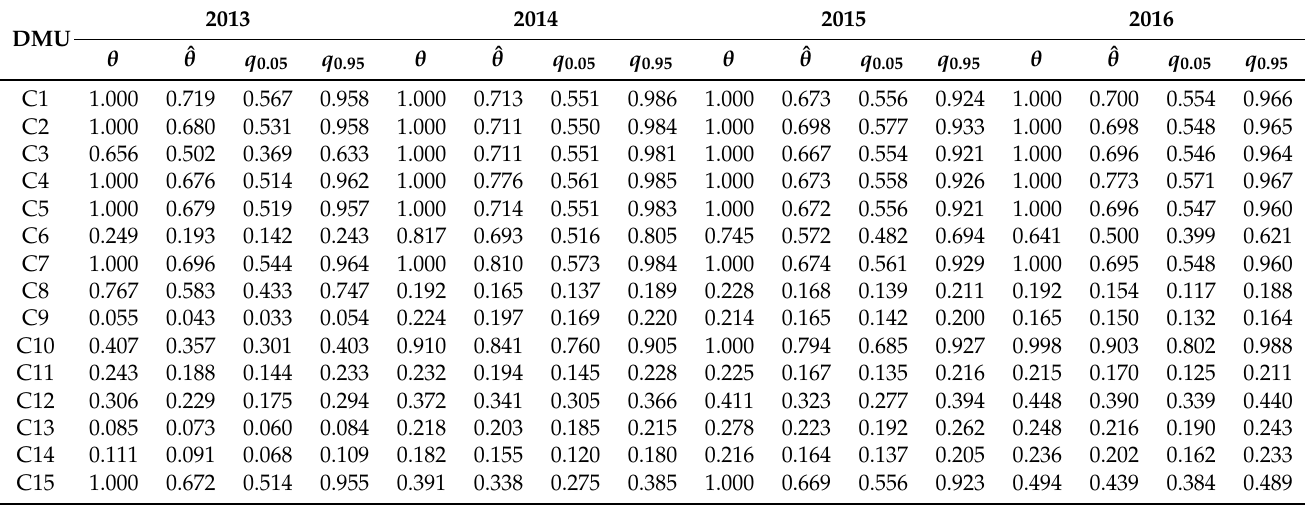
Table 5. Quality dimension efficiencies, bias-corrected bootstrap efficiencies, and